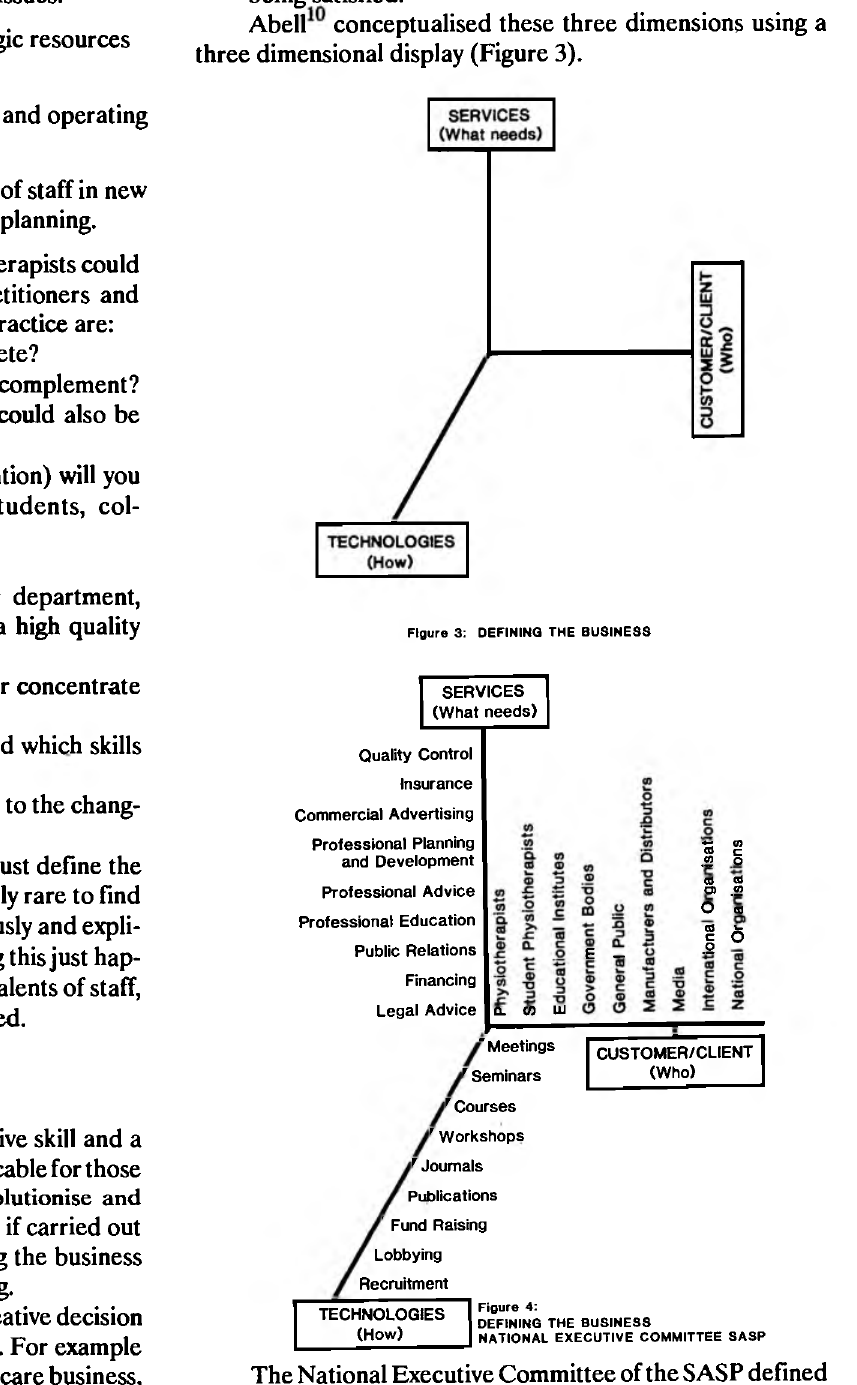
Figure 4: DEFINING THE BUSINESS NATIONAL EXECUTIVE COMMITTEE SASP The National Executive Committee of the SASP